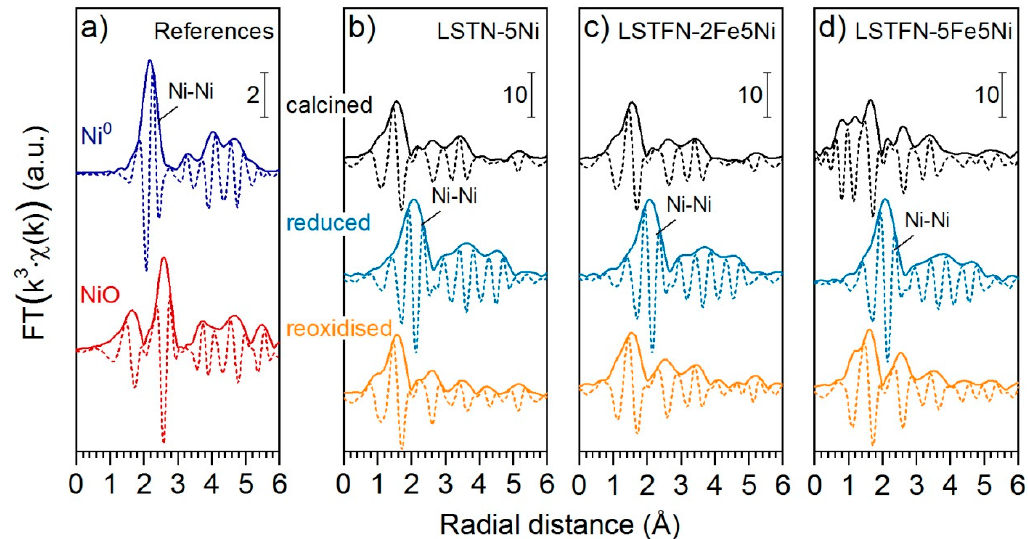
Figure 8. Fourier transformed k 3 -weighted Ni K-edge EXAFS data obtained for ( a ) Ni 0 (Ni foil) and NiO reference materials, as well as calcined, reduced (10 vol.% H 2 /Ar, 800 ◦ C, 1 h) and reoxidized (20 vol.% O 2 /N 2 , 800 ◦ C, 2 h) ( b ) LSTN-5Ni, ( c ) LSTFN-2Fe5Ni and ( d ) LSTFN-5Fe5Ni. Features are labelled on the reduced materials according to the underlying Ni-Ni scattering paths.